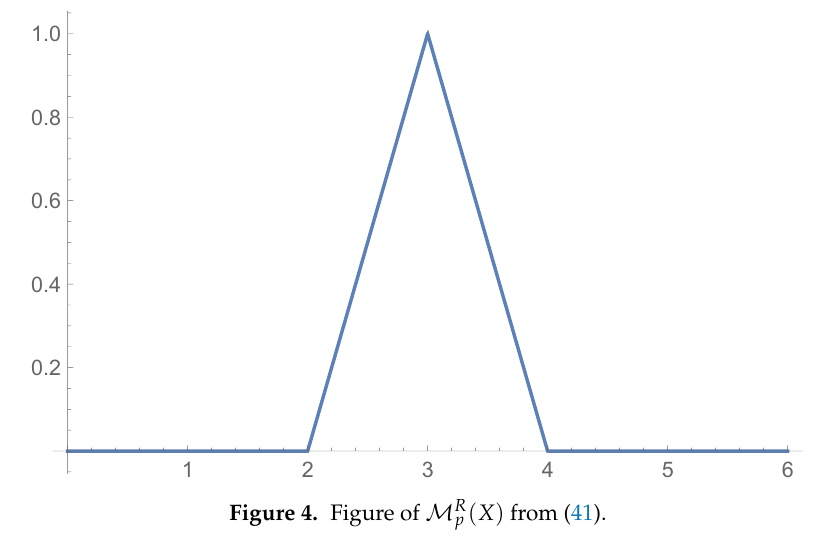
Figure 4. Figure of M R p ( X ) from